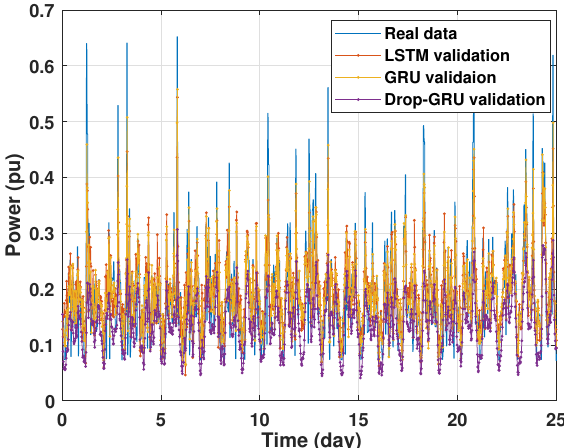
Figure 11. Training and validation for 7 days